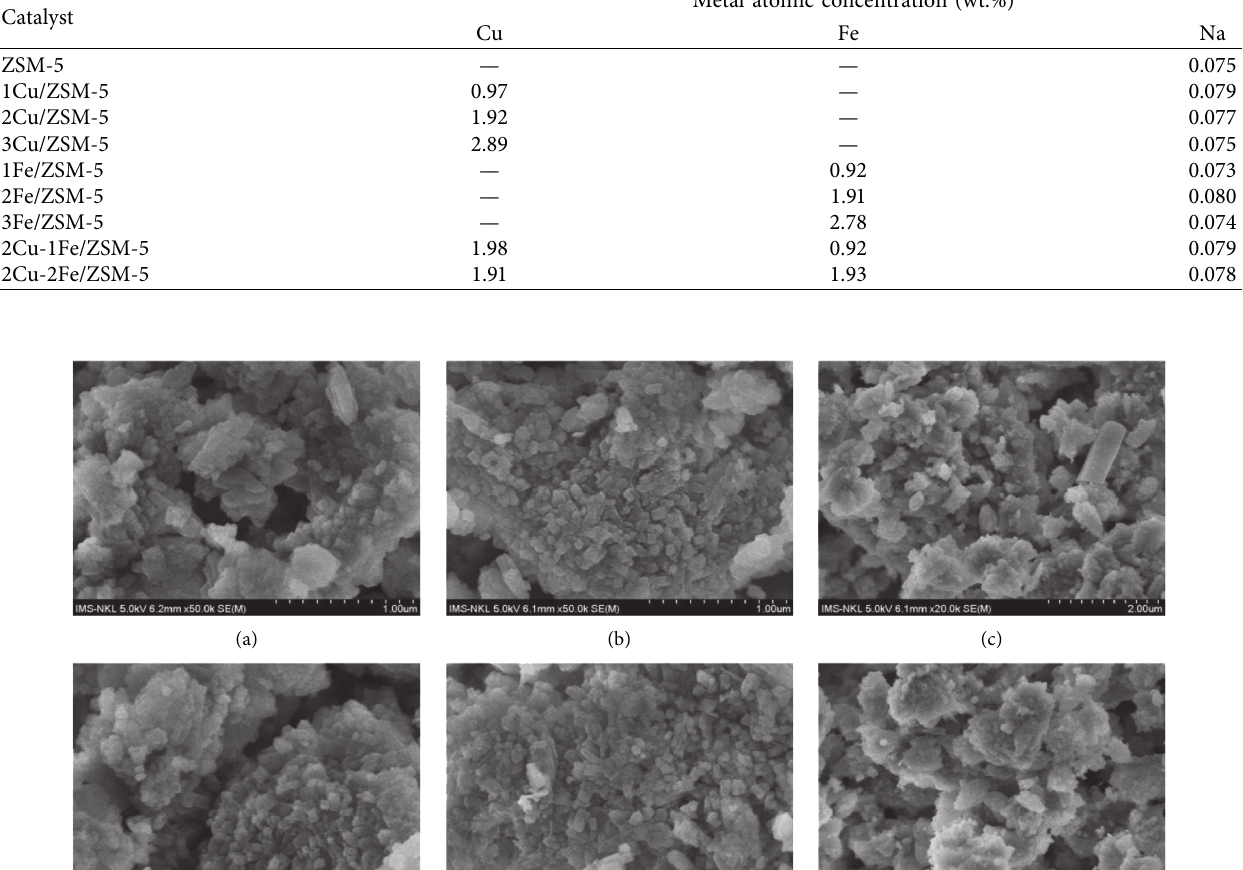
Table 1: Fe, Cu, and Na amounts in all catalysts obtained by EDS. Catalyst